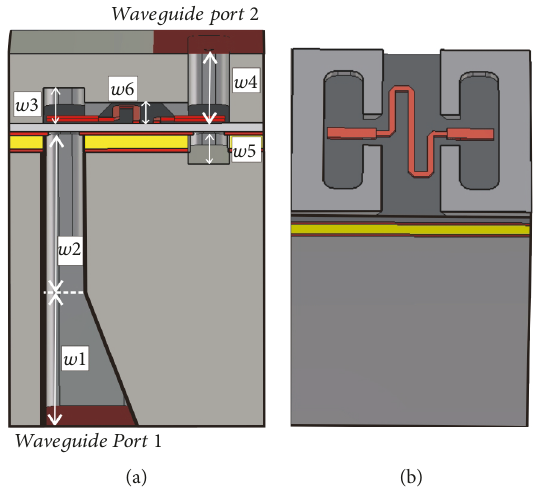
Figure 6: Simulation model of the waveguide-to-PCB transition, phase shifter, and the PCB-to-waveguide transitions. (a) Side-cut view and (b) top-cut view. Although the transitions look the same, there are di ff erences between them because they are located on opposite sides of the PCB.